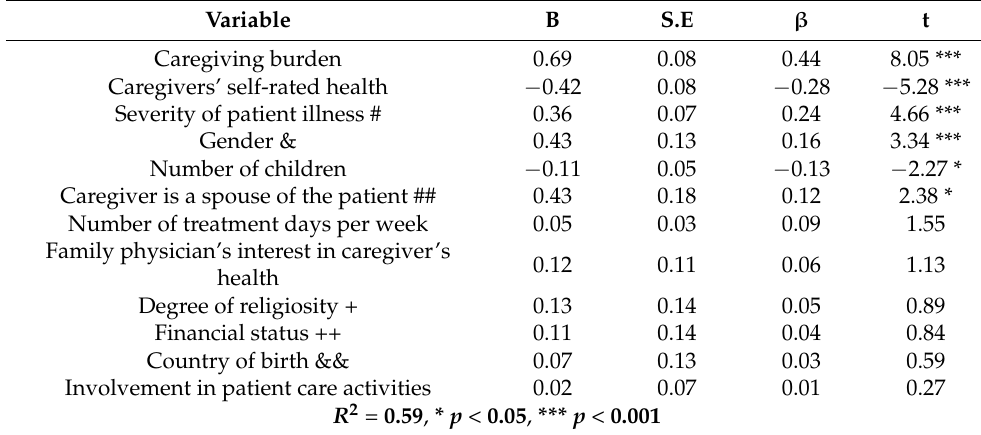
Table 4. Results of final linear regression analysis to explain the level of caregivers’ awareness of health risks ( n =